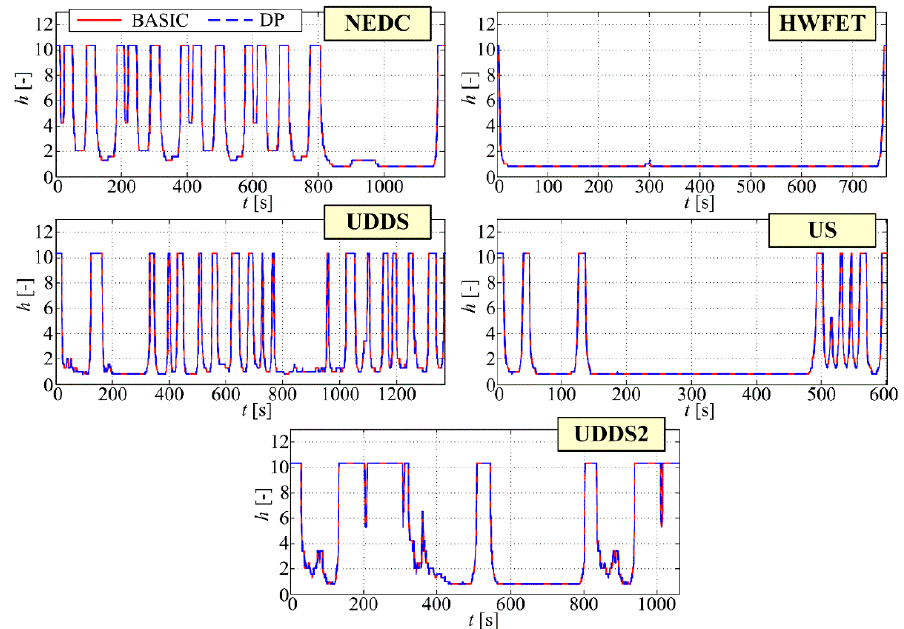
Figure 14. Gear ratios h of BASIC management strategy presented parallel to optimum gear ratios obtained by DP optimization for different driving cycles.